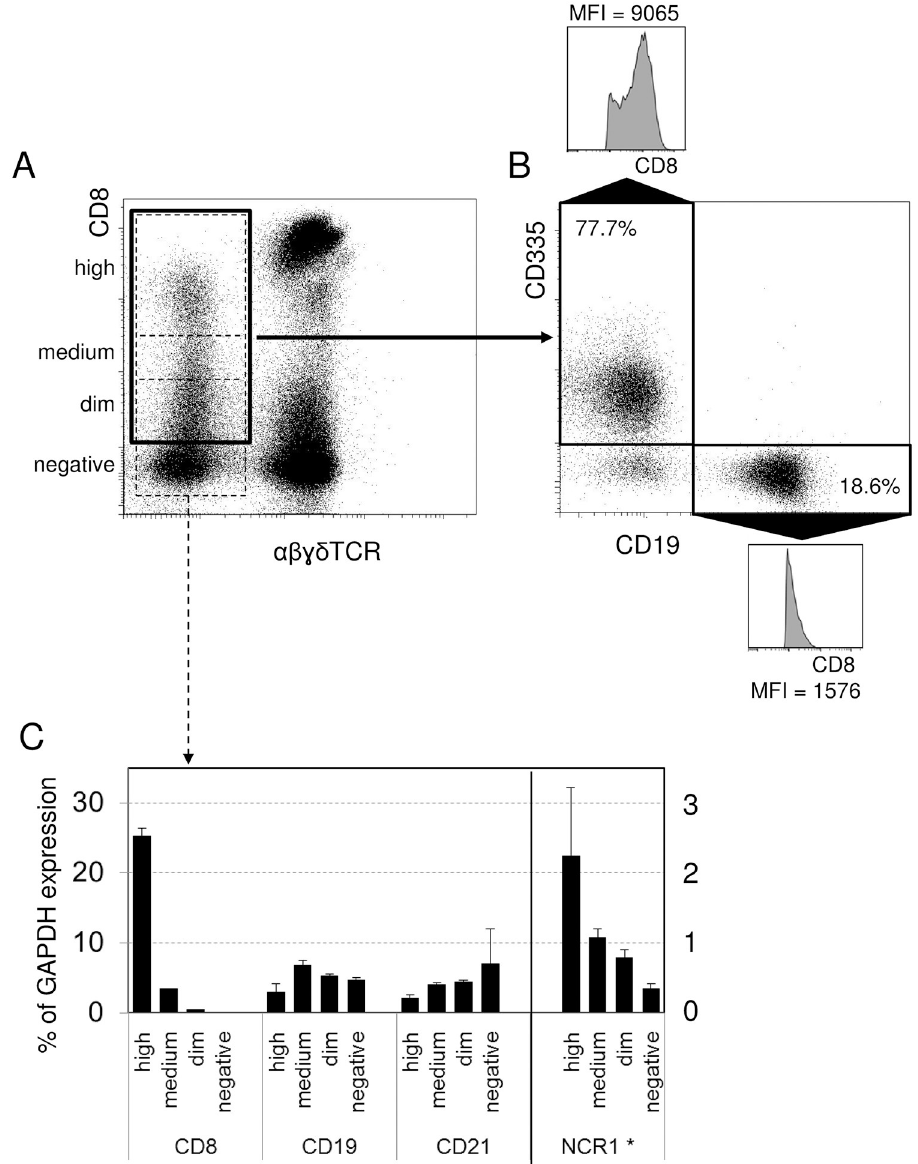
Fig 1. A phenotypically CD8 positive subset of human B cells. Mobilized apheresis material was analyzed with multicolor flow cytometry. The CD8+ TCR negative population was gated (A), and the cells included in the thick black gate resolved using the markers CD335 for NK cells and CD19 for B cells (B). Percentage of both populations is given in the quadrants, and black arrows point to the CD8 expression profiles and MFI values of the boxed CD335+ NK cells and CD19+ B cells, respectively. One representative donor out of four shown. (C) TCR-negative cells were flow sorted into CD8 high, CD8 medium, and CD8 dim populations along with TCR-CD8- cells as negative controls, as indicated by the dashed boxes on panel (A). Expression of genes in the sorted population was then measured by quantitative real-time PCR, and is shown as percentage of the GAPDH housekeeping gene ( � for NCR, encoding CD335, the scale on the right hand side applies). One representative donor out of two